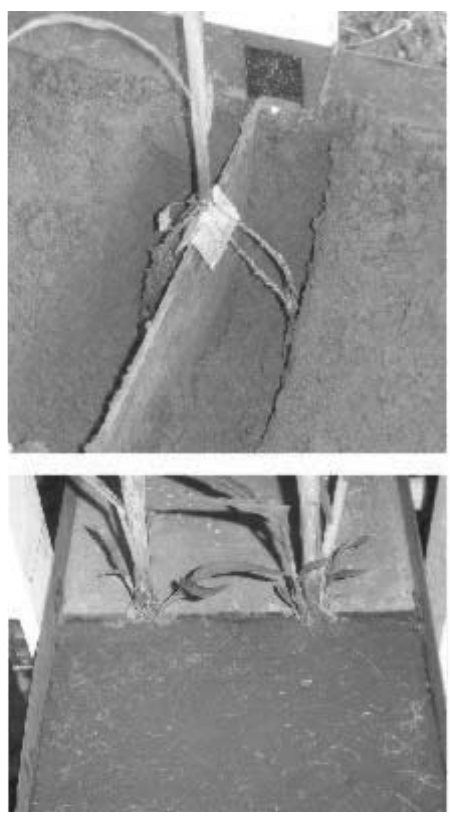
Figura 2. Posição de uma planta e divisão de seu sistema radicular nos compartimentos de um lisímetro no momento do transplante (esquerda) e disposição das plantas já na fase adulta